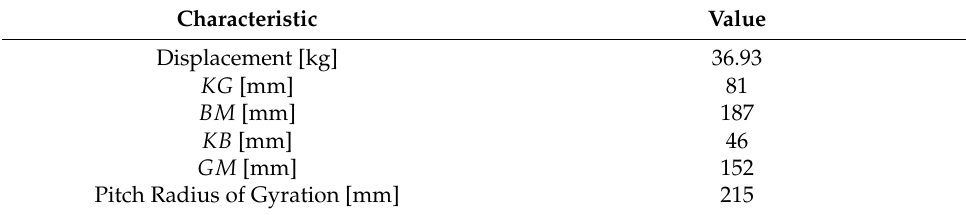
Table 1. Main properties of the